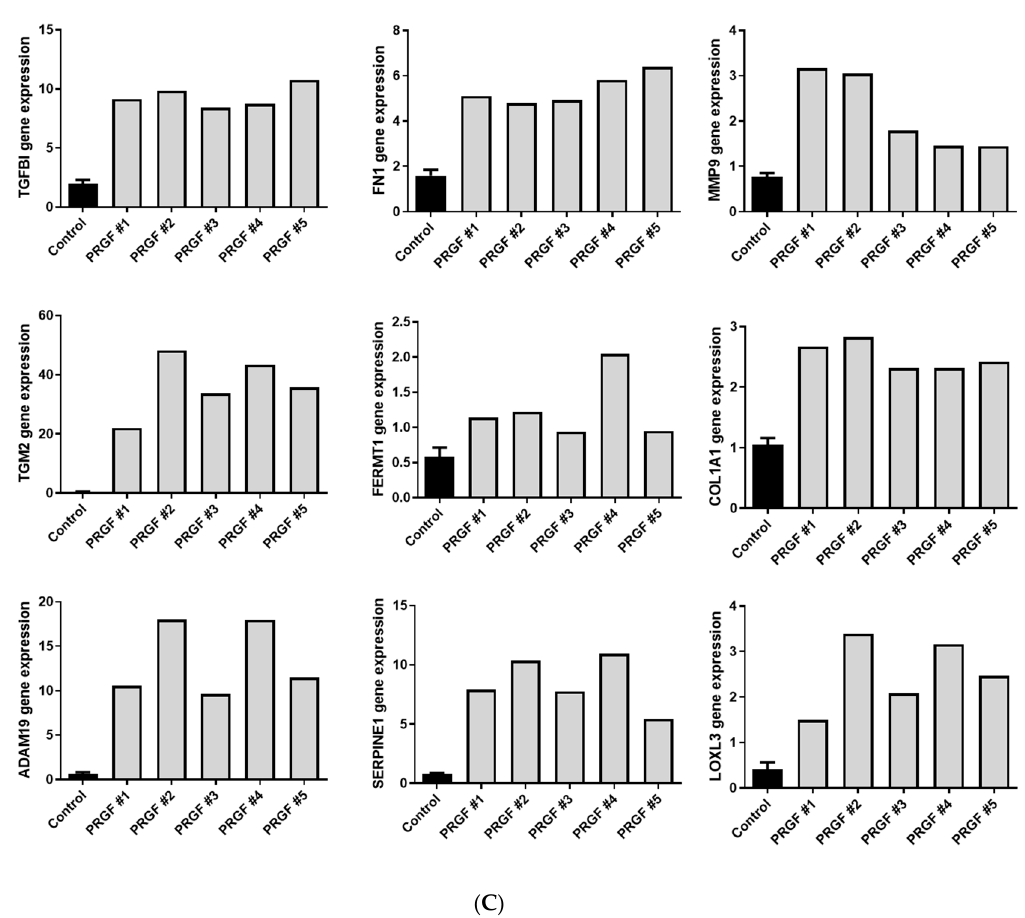
Figure 2. PRGF induces expression of various ECM-related factors in human fibroblasts. Human primary fibroblasts were stimulated for 24 h with PRGF (1:10) from 5 different donors (PRGF #1-PRGF #5). Relative gene expressions were determined by real-time PCR ( A , B ). Shown are induction levels of separate donors ( A ) or combined of all five different donors ( B ). Secretion of COL1A1 and FN1 was determined by ELISA ( C) . Shown are means ± s.e.m. ( n = 5, * p < 0.05, ** p < 0.01, Mann-Whitney U test).